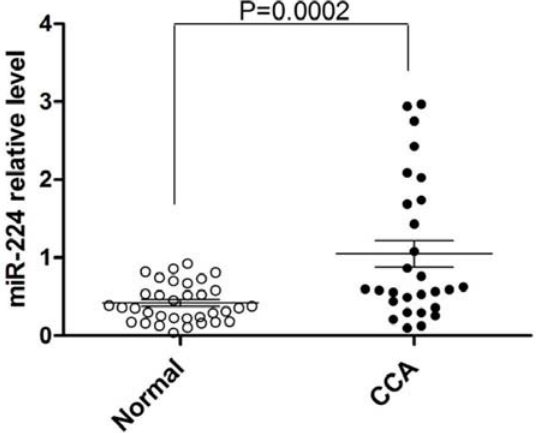
Figure 1. miR-224 is upregulated in CCA vs. normal biliary epithelium. The figure displays the mean and standard deviation of qRT-PCR-measured expression of miR-224 normalized to RNU6B for human CCA (filled circles) and normal liver tissues (open circles). Y-axis: qRT-PCR expression of miR-224 vs. RNU6B. Open circles indicate normal liver tissues and filled circles indicate CCA